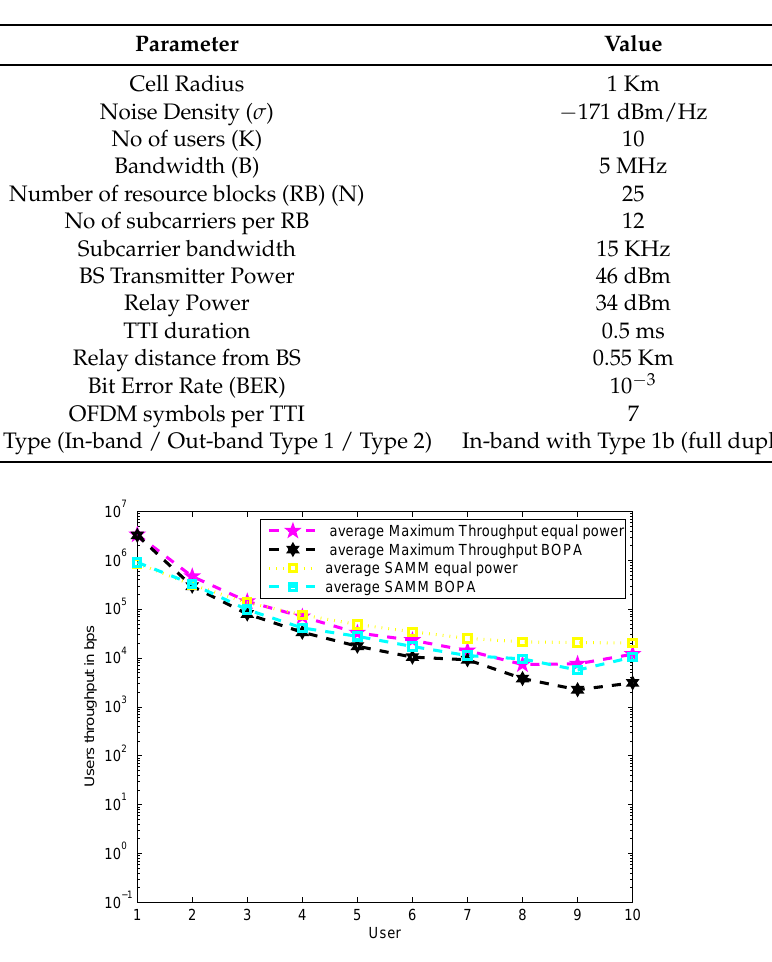
Table 2. Simulation Parameters.